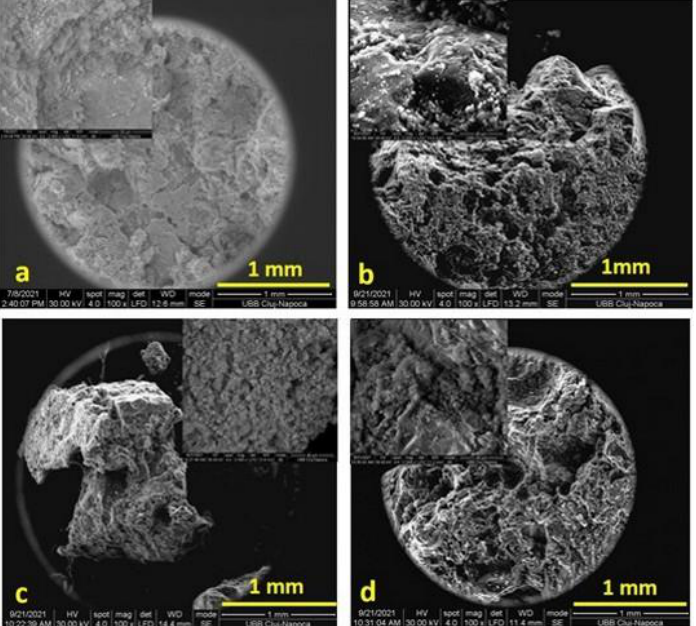
Figure 4. SEM images of M ( a ), M-GO 5% ( b ), M-GO-Ag-fly ash ( c ), and M-GO-ZnO-TiO 2 ( d ) at ×100 revealed a homogenous surface with differences in the texture.